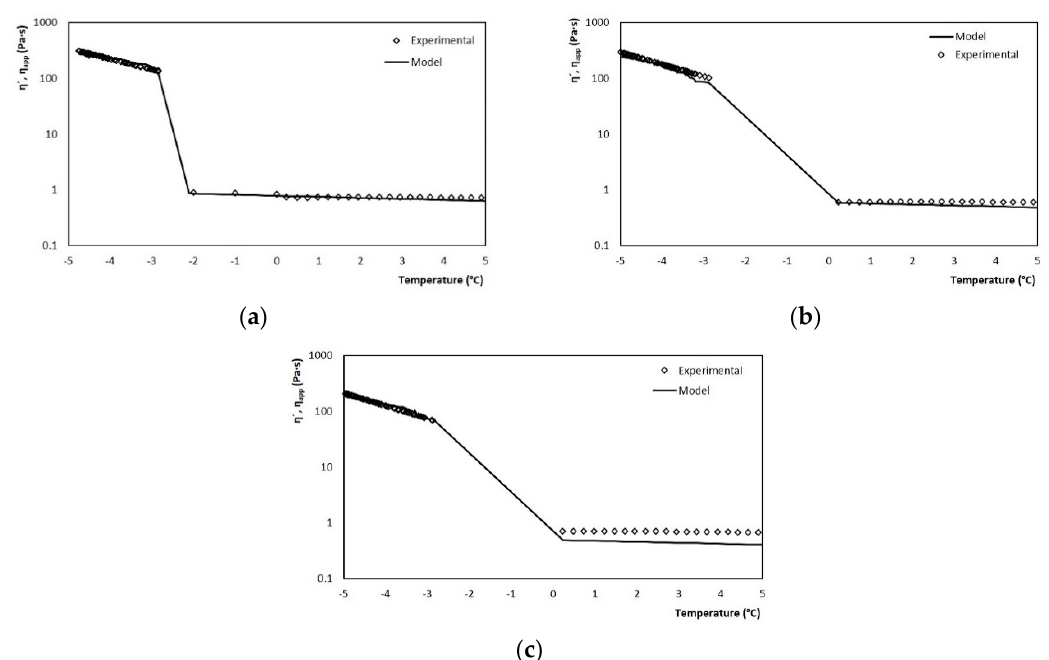
Figure 13. Comparison between experimental values and those estimated by the model for viscosity using the coupled model for rates of ( a ) 3.33, ( b ) 5.83 and ( c ) 8.33 s − 1 .